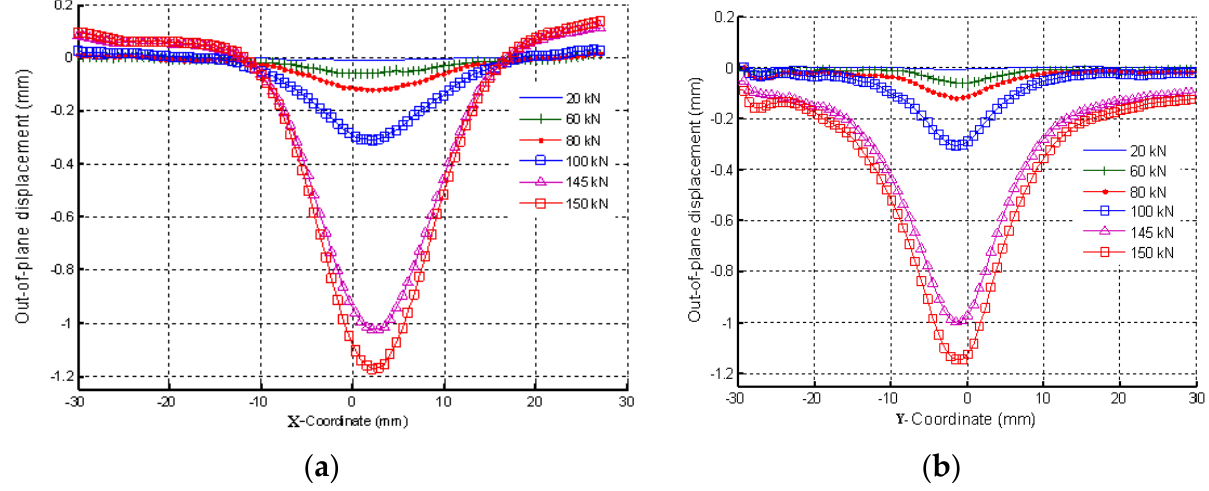
Figure 18. ( a ) Out-of-plane displacements on the cut plane (B) of Figure 10 at different compression loads. ( b ) Out-of-plane displacements on the cut plane (A) of Figure 10 at different compression loads (n.b. the curves were shifted slightly for clarity. In other words, the out-of-plane displacements were artificially increased to separate the curves from each other.)